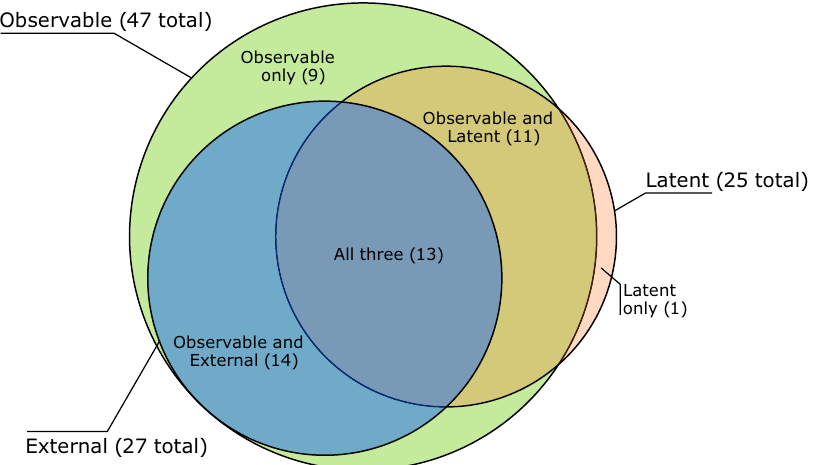
Fig. 5 Venn diagram of household water consumption determinants representation. The representation of different classes of determinants (observable, latent, and external) in the 48 reviewed framework analysis papers is represented with coloured circles. Intersections are also visualized. The size of each circle and the numerical labels indicate the number of studies in which each combination of determinant classes